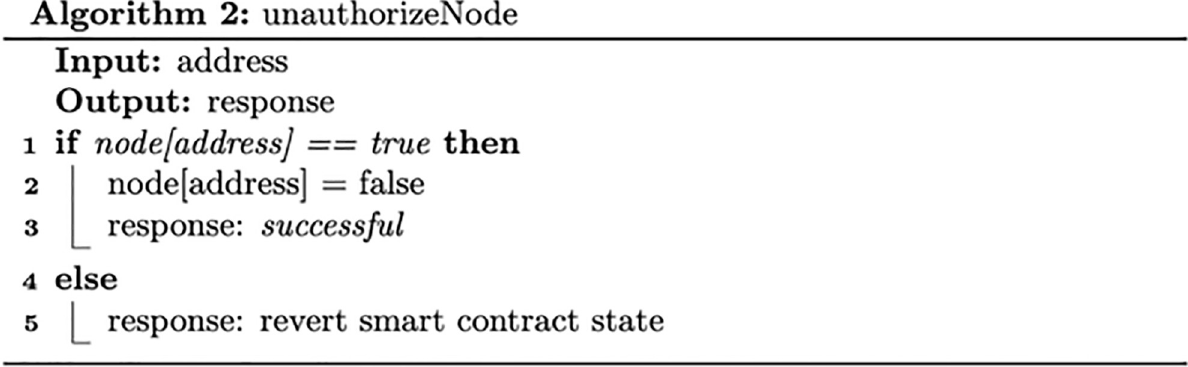
Fig 3. The revoking authorisation process for a given node.